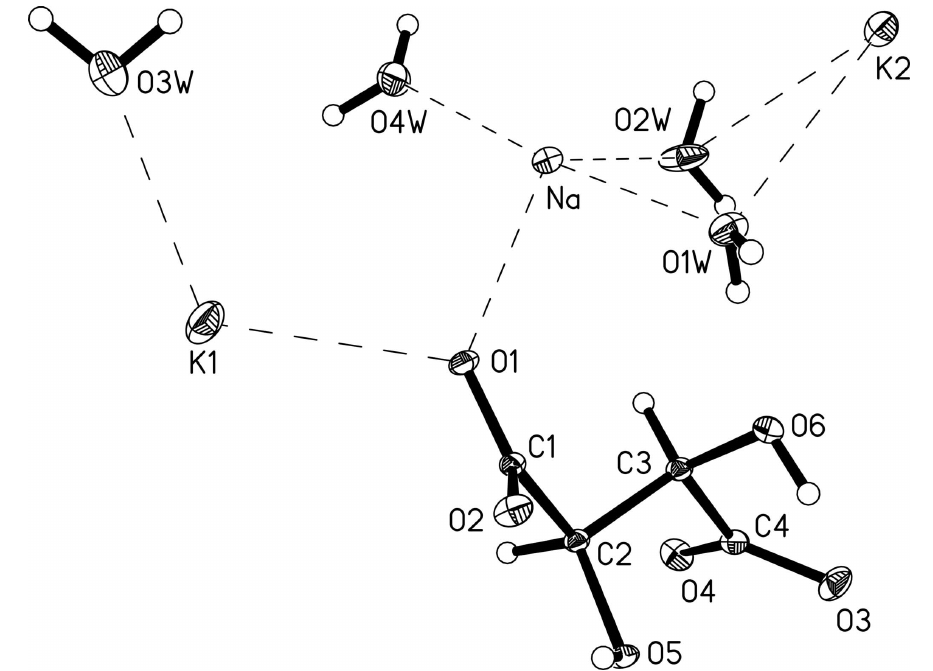
Figure 1 The molecular structure of (I). Displacement ellipsoids are shown at the 50% probability level. Metal ccordination has been indicated by dashed